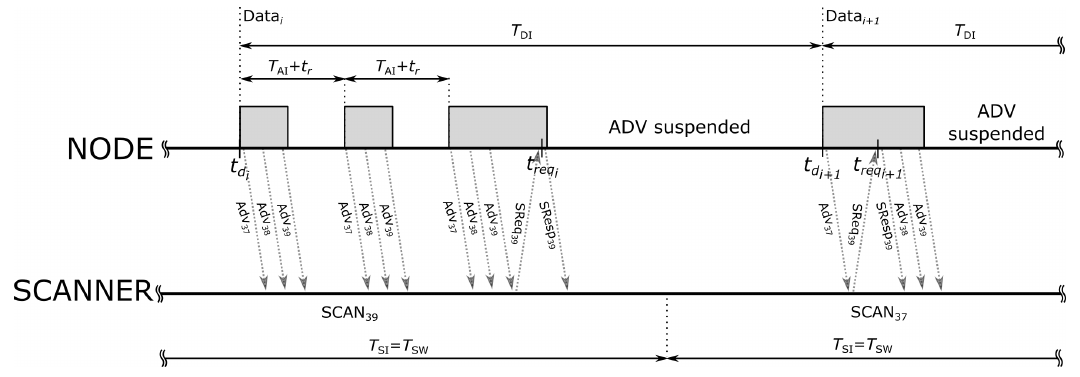
Figure 2. The three message communication scheme. The gray color marks the advertisement events that contain subsequent transmission of three ADVs on channels 37, 38 and 39. The node responds with SCAN_RESP and suspends further advertisement events when the first SCAN_REQ is